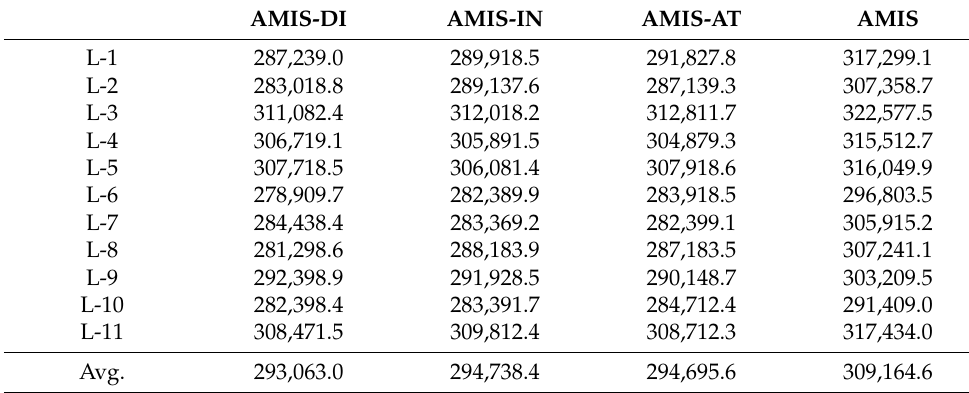
Table 20. Average profit per container using different AMIS